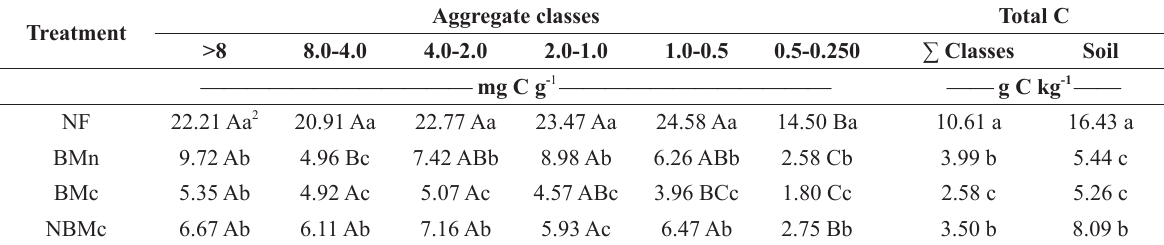
Different uppercase letters in the row and lowercase letters in the column indicate significant differences in the Tukey test (p<0.05).